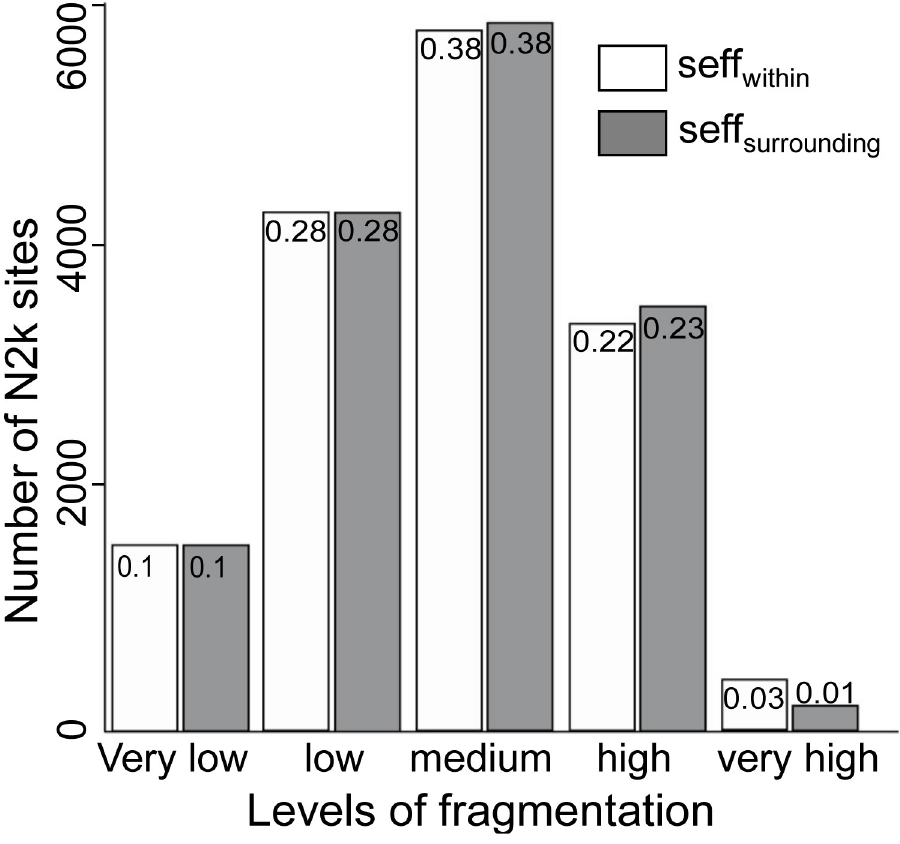
Fig 2. Number of N2k sites and their surroundings per fragmentation category. Fragmentation categories are based on EEA standards for effective mesh density (Table 3). Decimal numbers represent the relative amount of N2k sites which fall in one of the five fragmentation categories. The total number of N2k sites analyzed was 15390 (55.3% of N2k sites).